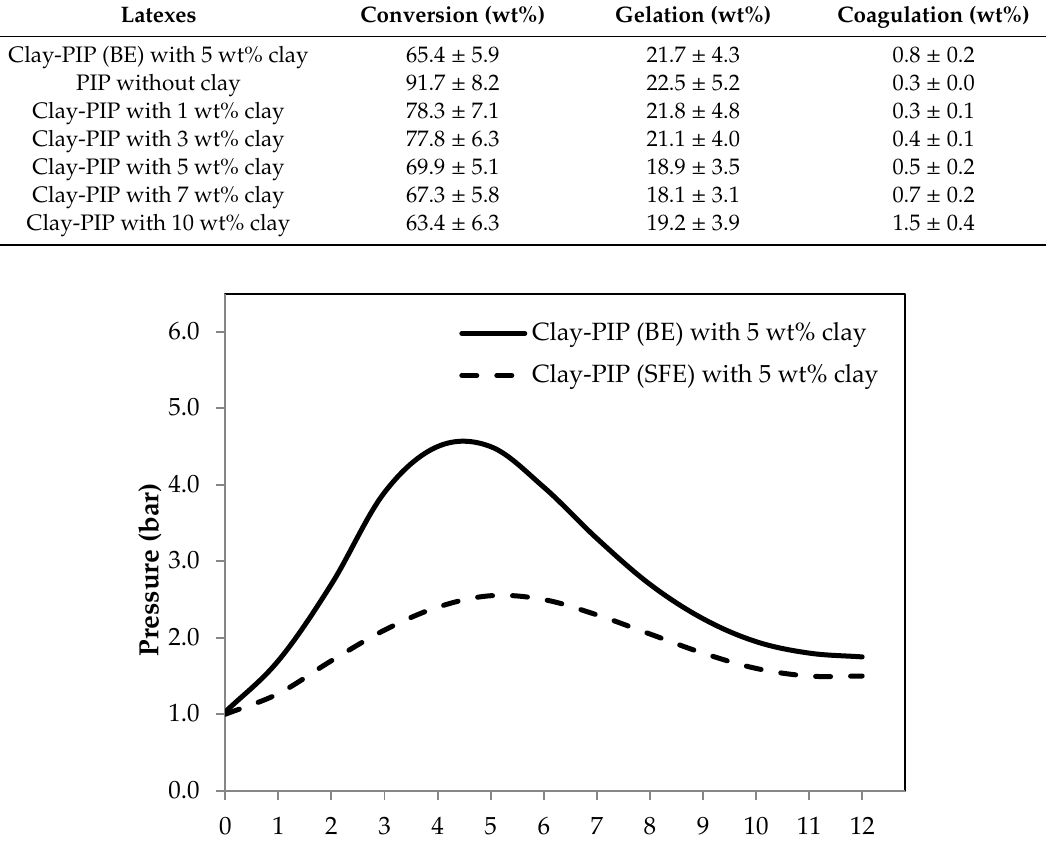
Table 3. Basic properties of the Clay-PIP latexes with di ff erent amounts of nanoclay prepared using batch (BE) and starve-fed (SFE) emulsion polymerization techniques.